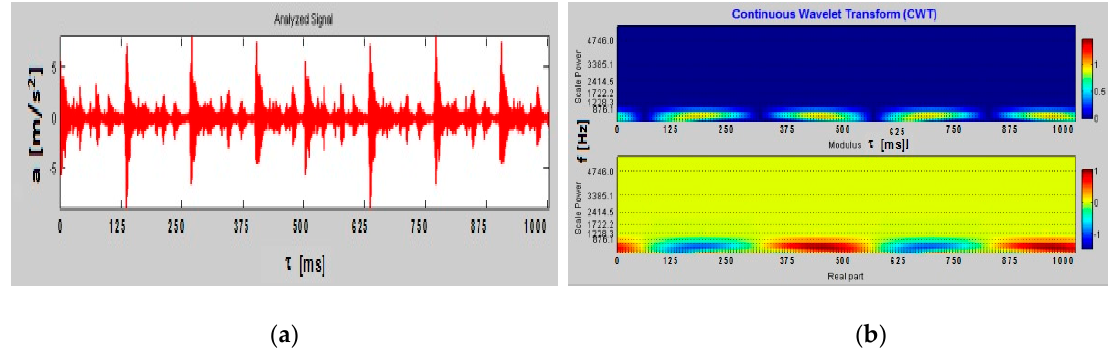
Figure 7. An example of original acceleration vibration signal ( a ) and continuous wavelet transform ( b ).